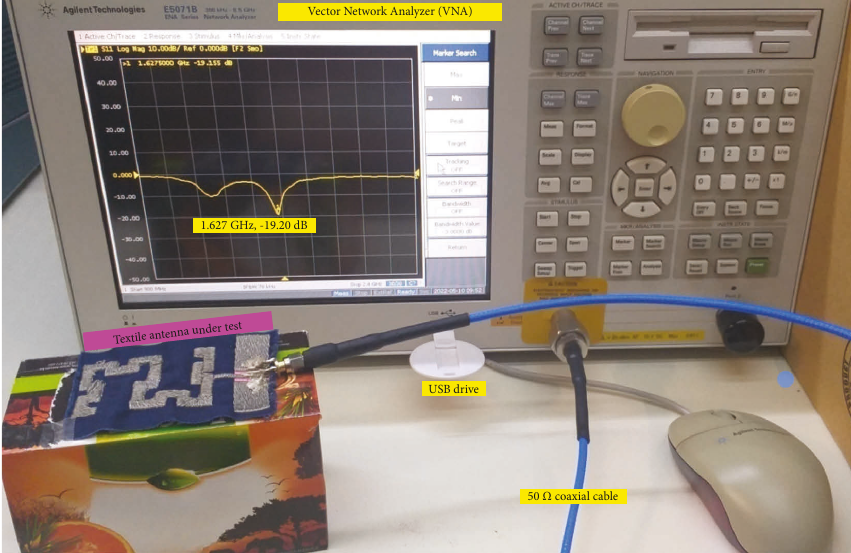
Figure 5: Measurement setup for the fabricated textile antenna.